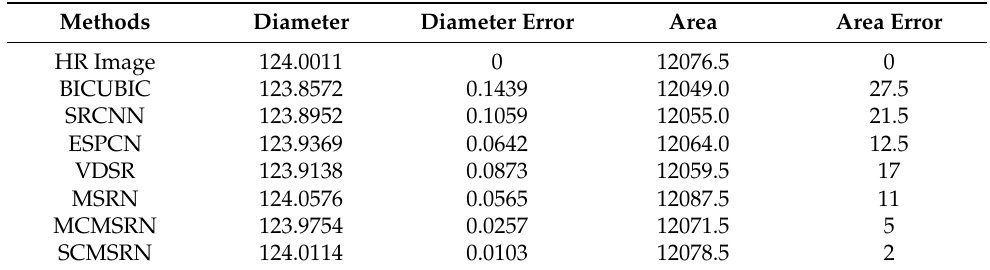
Figure 7. Contrast chart of image contours of melt images of liquid metal samples by algorithms x2. Table 3. The outline diameter and area of the melt image of the liquid metal sample extracted based on the Canny operator